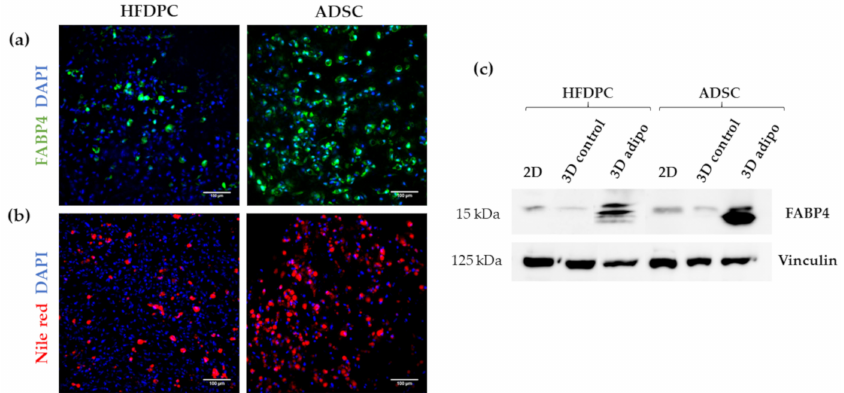
Figure 9. Characterization of adipogenic phenotype of HFDPC and ADSC cultured in RAD16-I sca ff old for 21 days. ( a ) FABP4 immunofluorescence of 3D constructs under adipogenic induction; ( b ) Nile red staining of 3D constructs under adipogenic induction; ( c ) FABP4 western blot of HFDPC and ADSC cultured in 2D cultures and in 3D RAD16-I sca ff old under control and adipogenic medium. Vinculin was used as an internal control. The image is representative of three